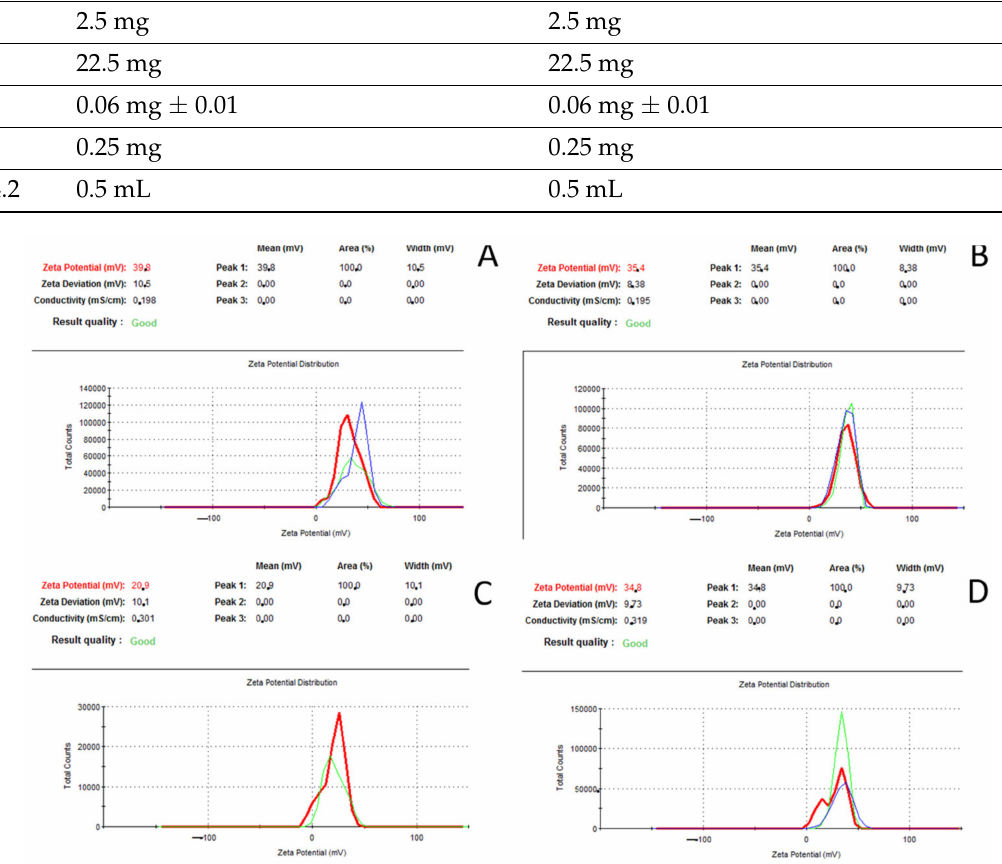
Figure 3. Zeta potential data of IFN β -1a: ( A , B ) ReciGen; ( C , D )